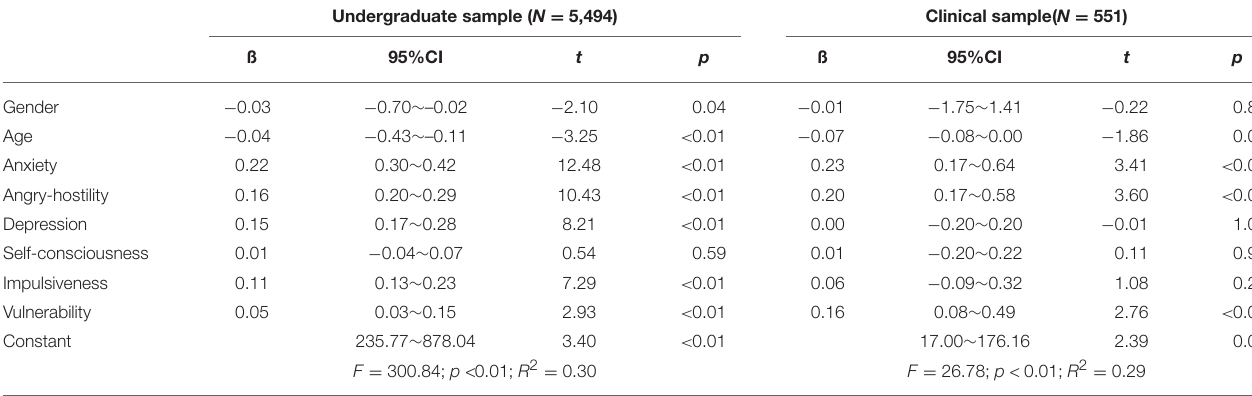
TABLE 8 | Multiple regression analysis with the SAS total score as the dependent